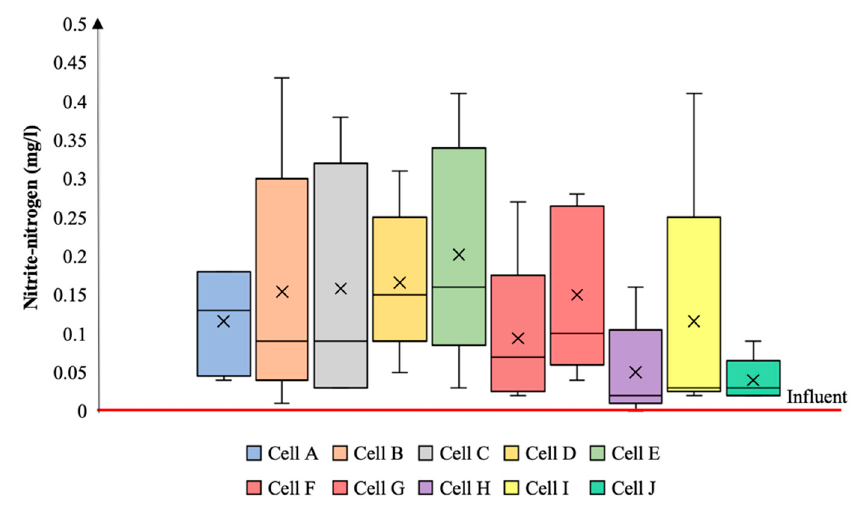
Figure 8. Concentration of nitrite-nitrogen. Sample number = 5; box plots show medians and 25th and 75th percentiles; whiskers represent the 10th and 90th percentiles.